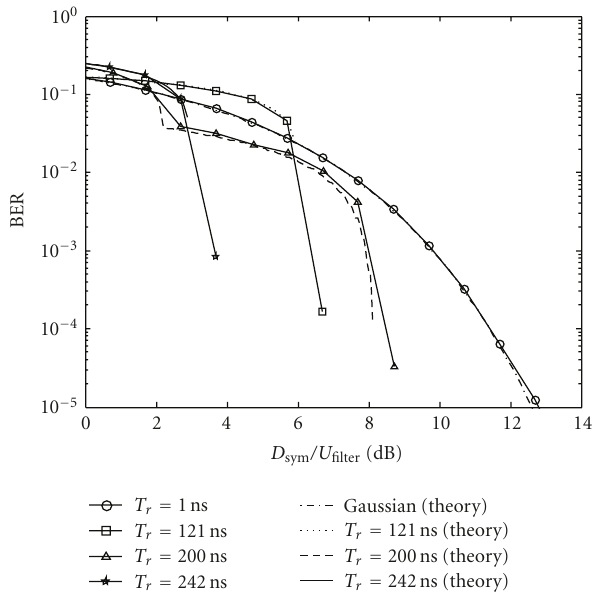
Figure 6: BER performance of OFDM signal compared to theoret- ical